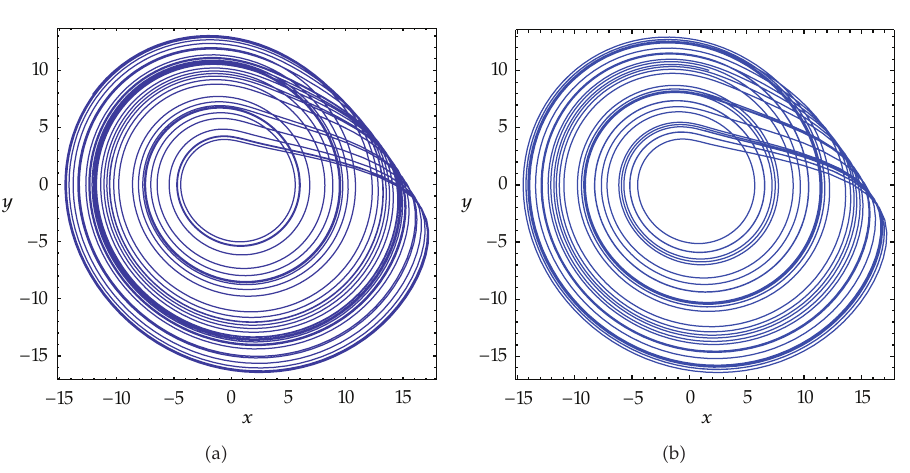
Figure 1: Phase plot of chaotic attractor in the x - y space, with a (cid:8) 0 . 15 and α 1 (cid:8) α 2 (cid:8) α 3 (cid:8) 1: (cid:3) a (cid:4) MSGDTM, (cid:3) b (cid:4)